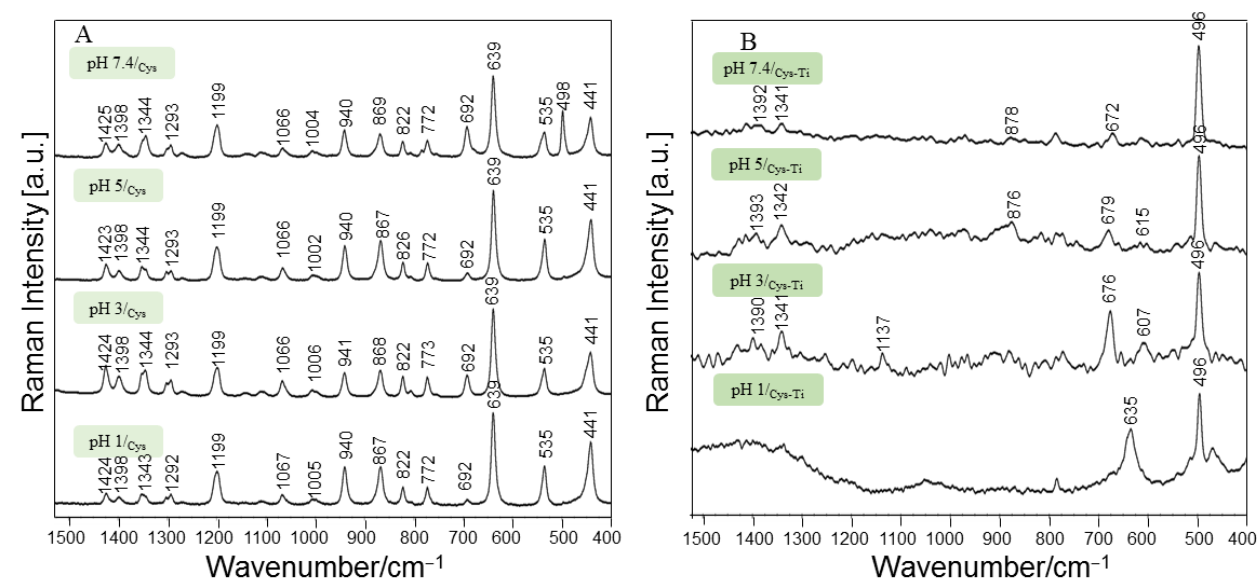
Figure 4. Raman spectra of Cys (10 −1 M/PBS) recorded at different pH values in the solid state ( A ) and ex situ SERS spectra of Cys (10 −2 M/PBS) recorded at different pH, after 24 h of exposure on the Ti surface in the dried system ( B ).